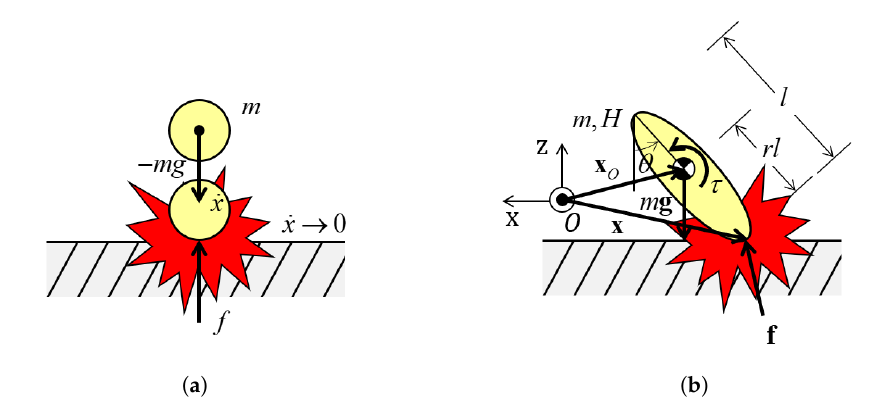
Figure 2. Impulse: ( a ) a point-mass; ( b ) a single rigid